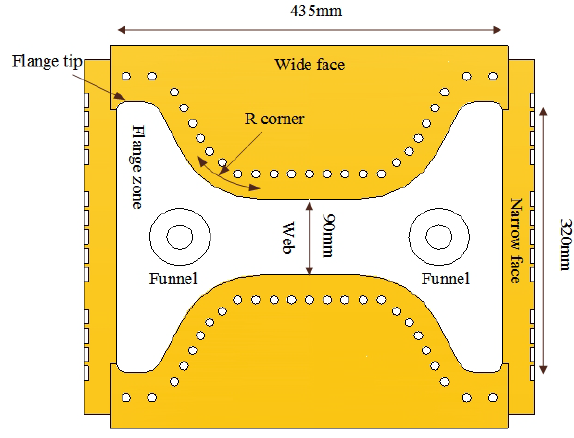
Figure 2. Schematic illustration of 435 mm ˆ 320 mm ˆ 90 mm beam blank